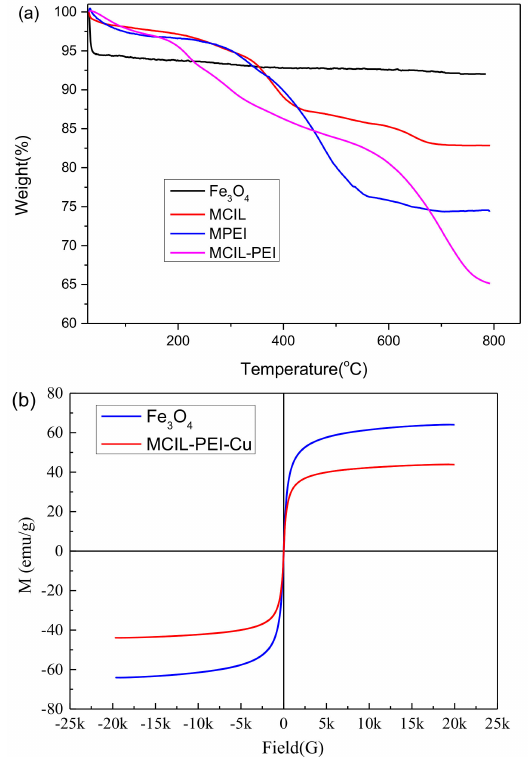
Figure 2. TGA curve ( a ) and magnetic hysteresis loops ( b ) of carriers.